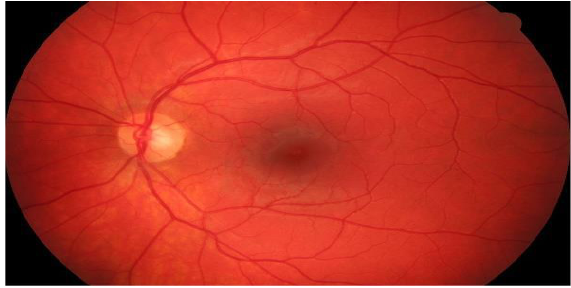
Figure 3.a. Cropped original image